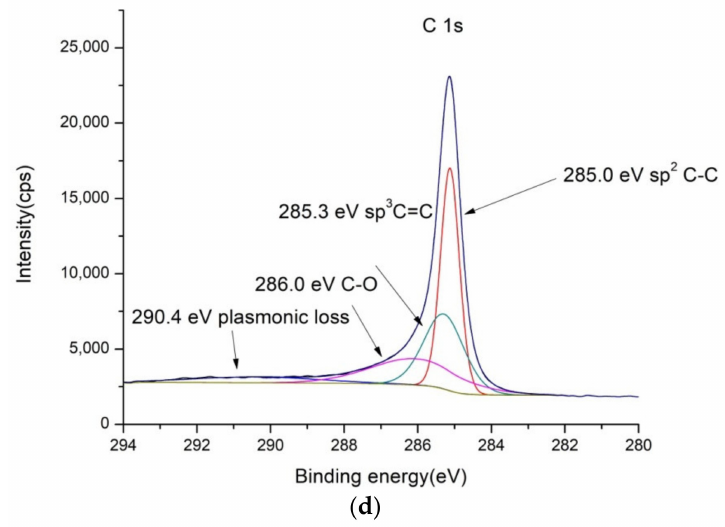
Figure 3. XPS spectra of PbO 2 /GNR: ( a ) low-resolution spectra, ( b ) high-resolution Pb 4f, ( c ) high- resolution O 1s and ( d ) high-resolution C 1s spectra.